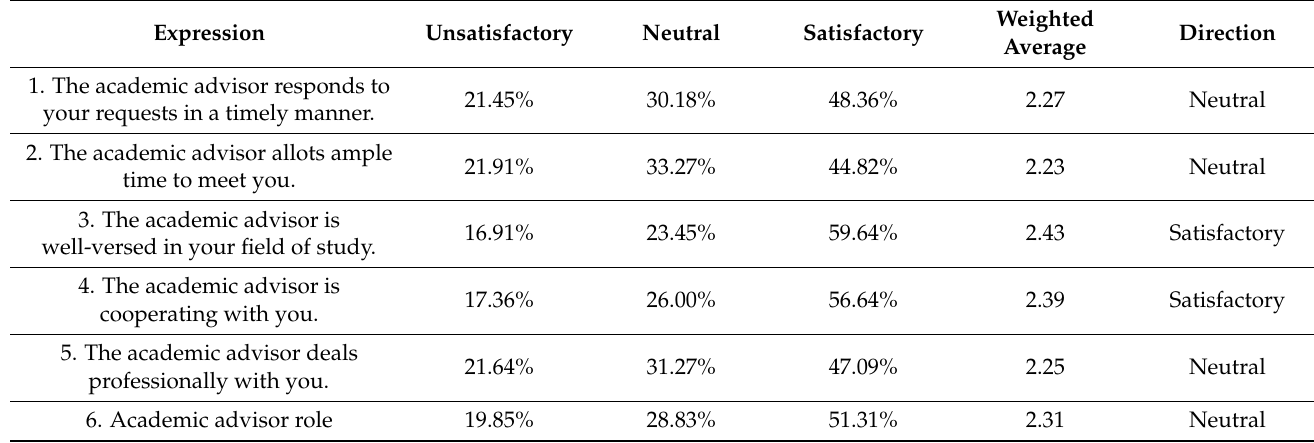
Table 12. Student trends concerning their academic advisors in 2018.